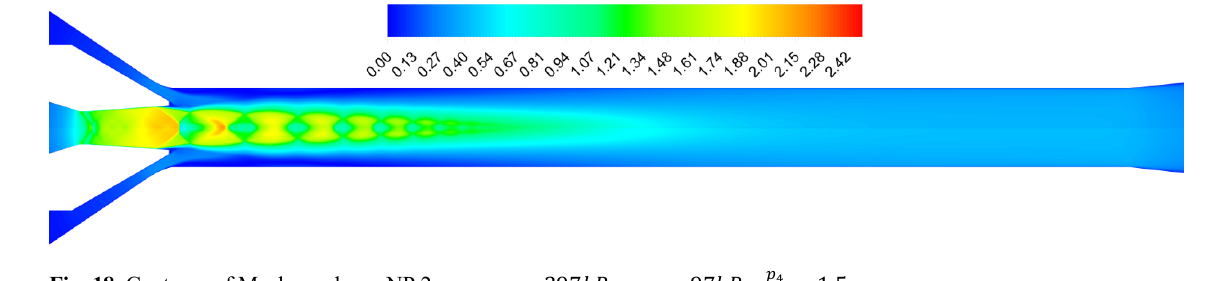
01 = 397𝑘𝑃𝑎,𝑝 02 = 97𝑘𝑃𝑎,